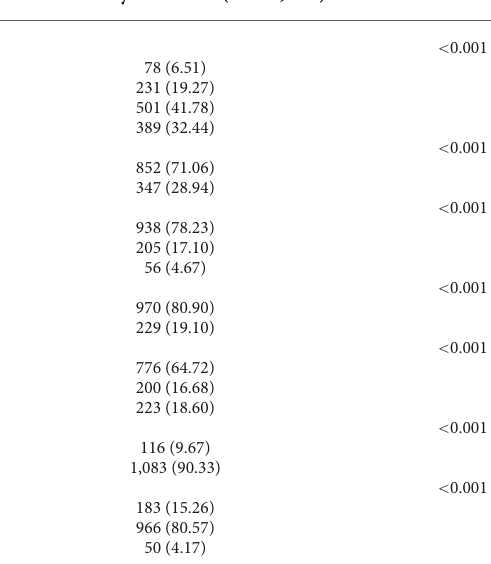
TABLE 1 Demographic characteristics of the participants between groups with and without cognitive impairment (CI) 3 years later ( N (%)). Variables Without CI 3 years later (N =